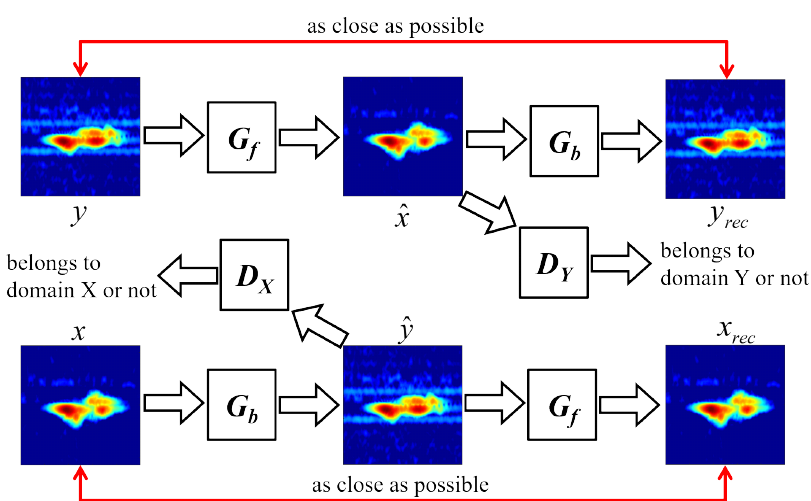
Figure 3. The overall architecture of the proposed de-wiring Cycle GAN method. The network consists of two mapping functions: G f : Y → X and G b : X → Y , and corresponding discriminators D X and D Y . The cycle consistency is shown: G b ( G f ( Y )) ≈ Y and G f ( G b ( X )) ≈ X